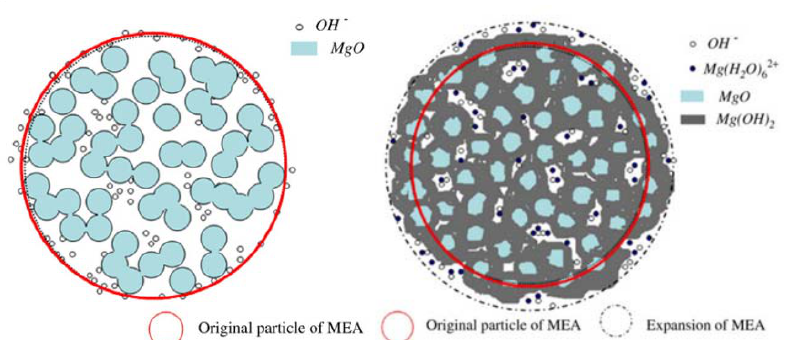
Figure 9. Hydration and expansion model of the porous MEA with high activity in the cement paste. Reprinted with permission from Professor Mo Liwu, Copyright 2009 Elsevier Ltd. [34].